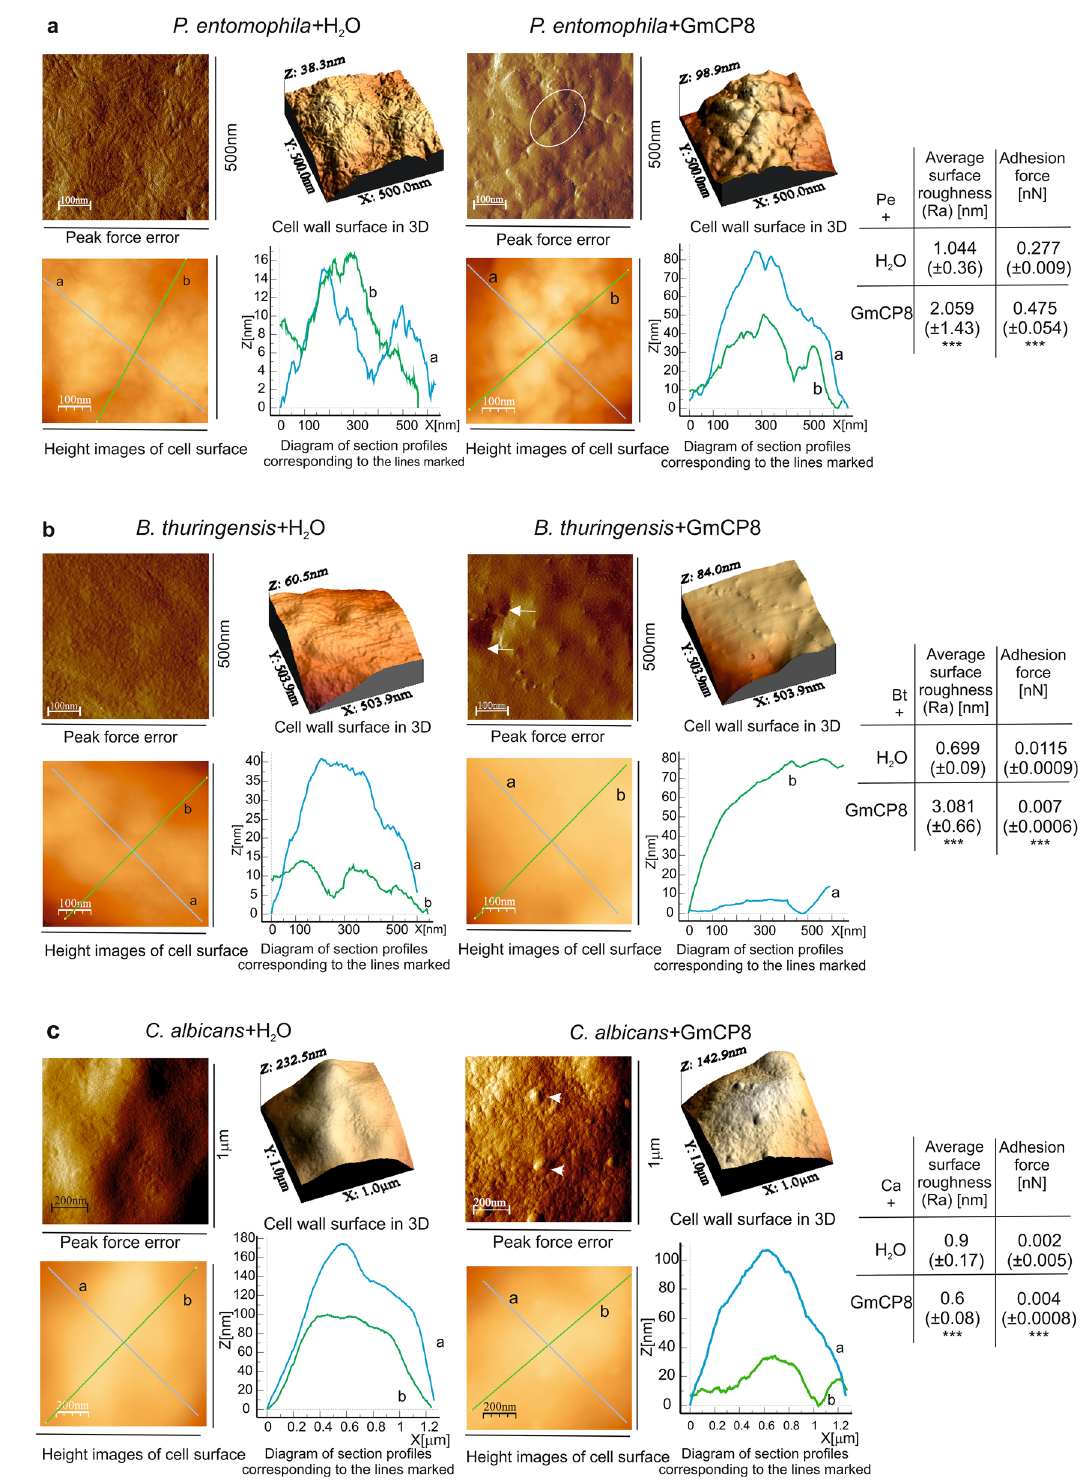
Figure 4. Effect of the GmCP8 protein on ( a ) P. entomophila, ( b ) B. thuringiensis , and ( c ) C. albicans cell surface topography. The microorganisms in the logarithmic growth phase were incubated without (water) or with the GmCP8 protein for 1 h. Then, the cells were imaged by AFM. The peak-force-error, three-dimensional (upper panels in each part), and height images are presented (area of 500 nm × 500 nm for Pe , 1 µm × 1 µm for Bt and Ca ) as well as cell surface change profiles measured along lines a and b marked in the height image (lower panels in each part). The alterations in the cell surface are marked by: ( a ) white ellipse indicating grooves; ( b ) white arrows show holes; c white arrowheads indicate lumps. The tables show biophysical parameters of the cell surface, such as roughness and adhesion force values. Mean values ± SD are shown, n = 114. Significant differences are indicated *p < 0.05, **p < 0.01, ***p < 0.001 (Mann–Whitney U test). The images were taken using Nanoscope Analysis vl. 40 (Veeco), the section profiles and three-dimensional (3D) images of the cells were generated using WSxW 5.0 software (Nanotec, Spain) 66